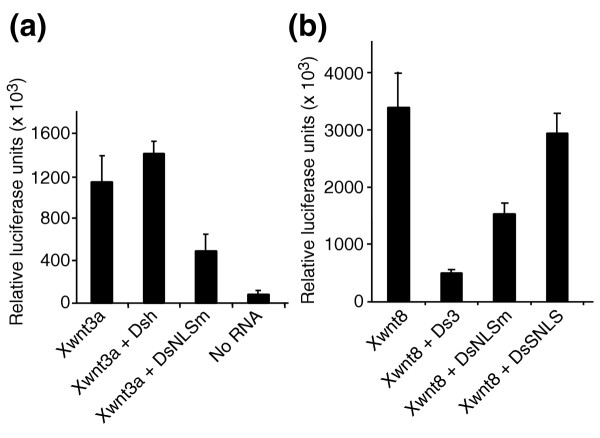
Dominant inhibition of Wnt-dependent transcription by Dsh mutants. Eight-cell embryos were injected (a) in one animal ventral blastomere or (b) in one vegetal ventral blastomere with -833pSia-Luc DNA (20 pg), mRNAs encoding Xwnt3a (5 pg) or Xwnt8 (2 pg), and Dsh-GFP, DsNLSm, Ds3 or DsSNLS mRNA (0.5 ng) as indicated. Luciferase activity was measured as described in Figure 5b.